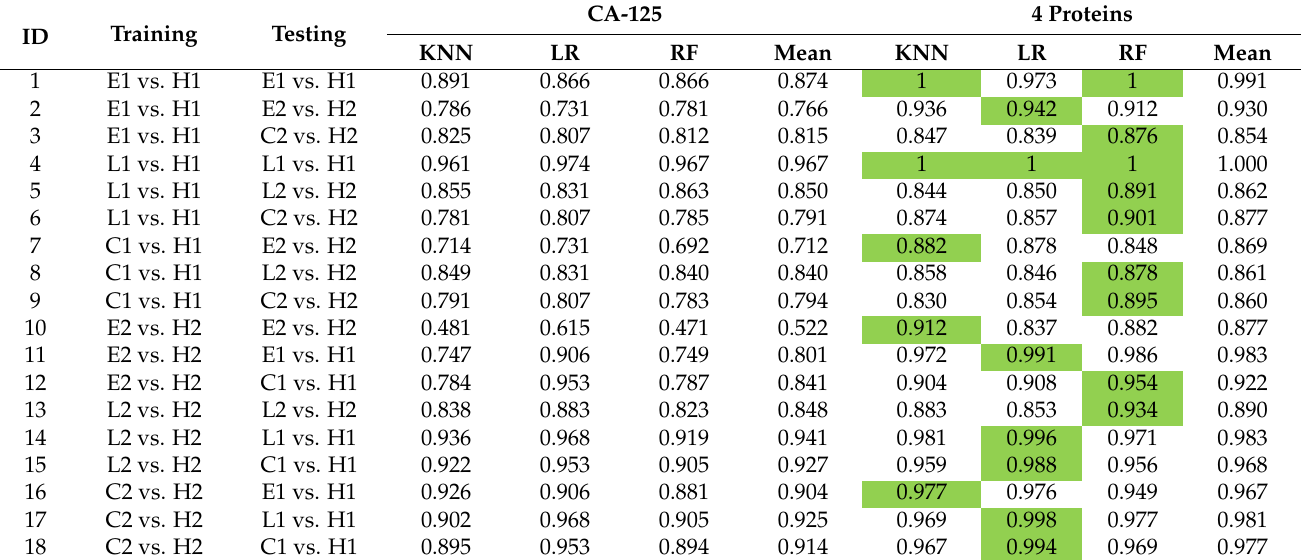
Table 7. The comparison of the area under the ROC (AUC) between CA-125 alone and all four proteins (CA-125, MIF, OPN, and PROL) when using three classification techniques, namely K-Nearest Neighbor (KNN), Logistic Regression (LR), and Random Forest (RF) (the AUC is not available for Support Vector Machine), in various experiments. The AUC measures the performance of the model across all possible classification thresholds. Since SVM has a fixed classification threshold, the AUC is not useful and hence removed from the comparison. We highlighted the cell(s) with best in each experiment. In general, using random forest and all four proteins yield the best results on most